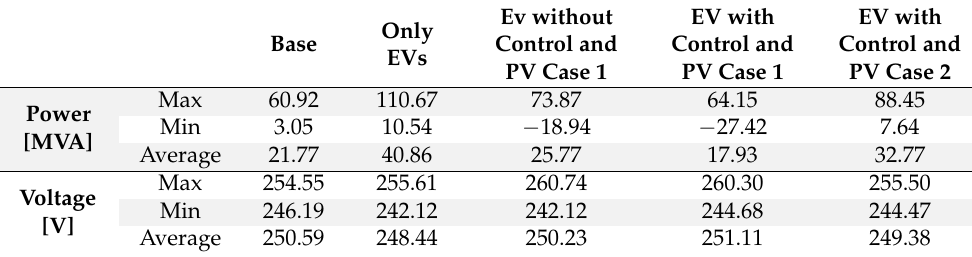
Table 1. Simulation